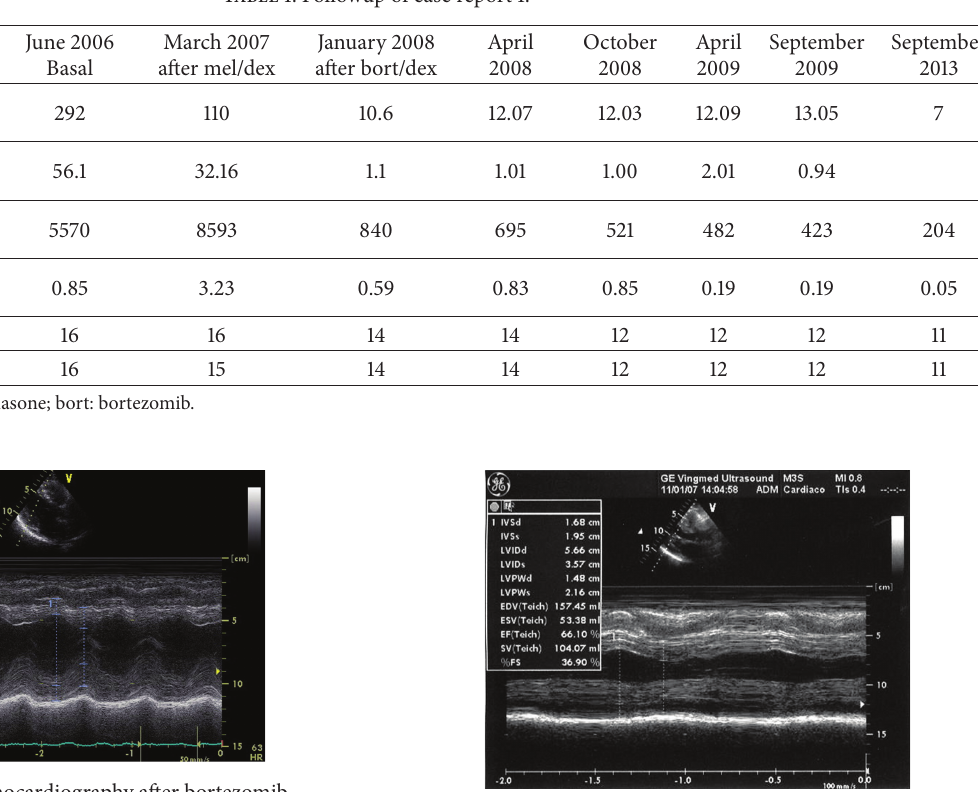
Figure 1: Case 1: echocardiography before bortezomib. Table 1: Followup of case report 1.